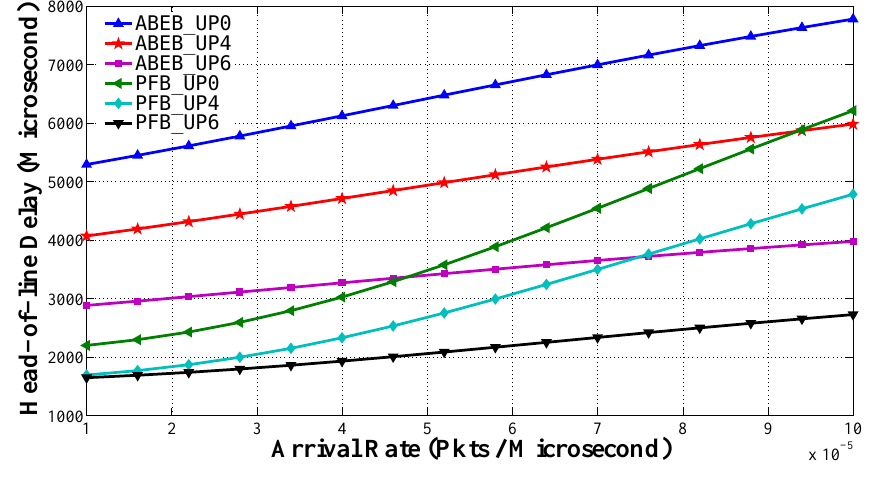
Figure 14. Mean frame service time of UP s in the heterogeneous case for different backoff algorithms.